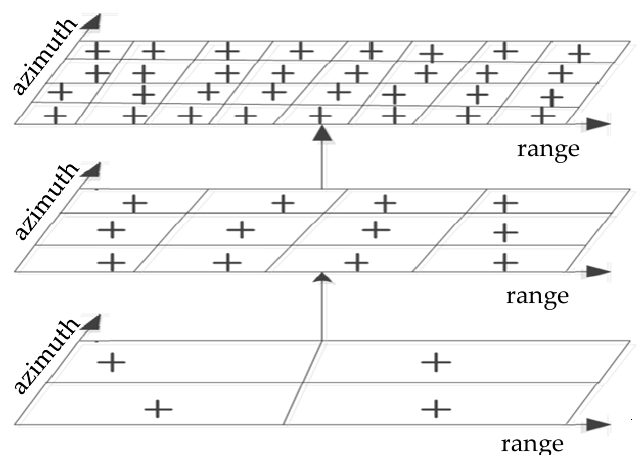
Figure 4. Hierarchical surface fitting with decreasing grid.